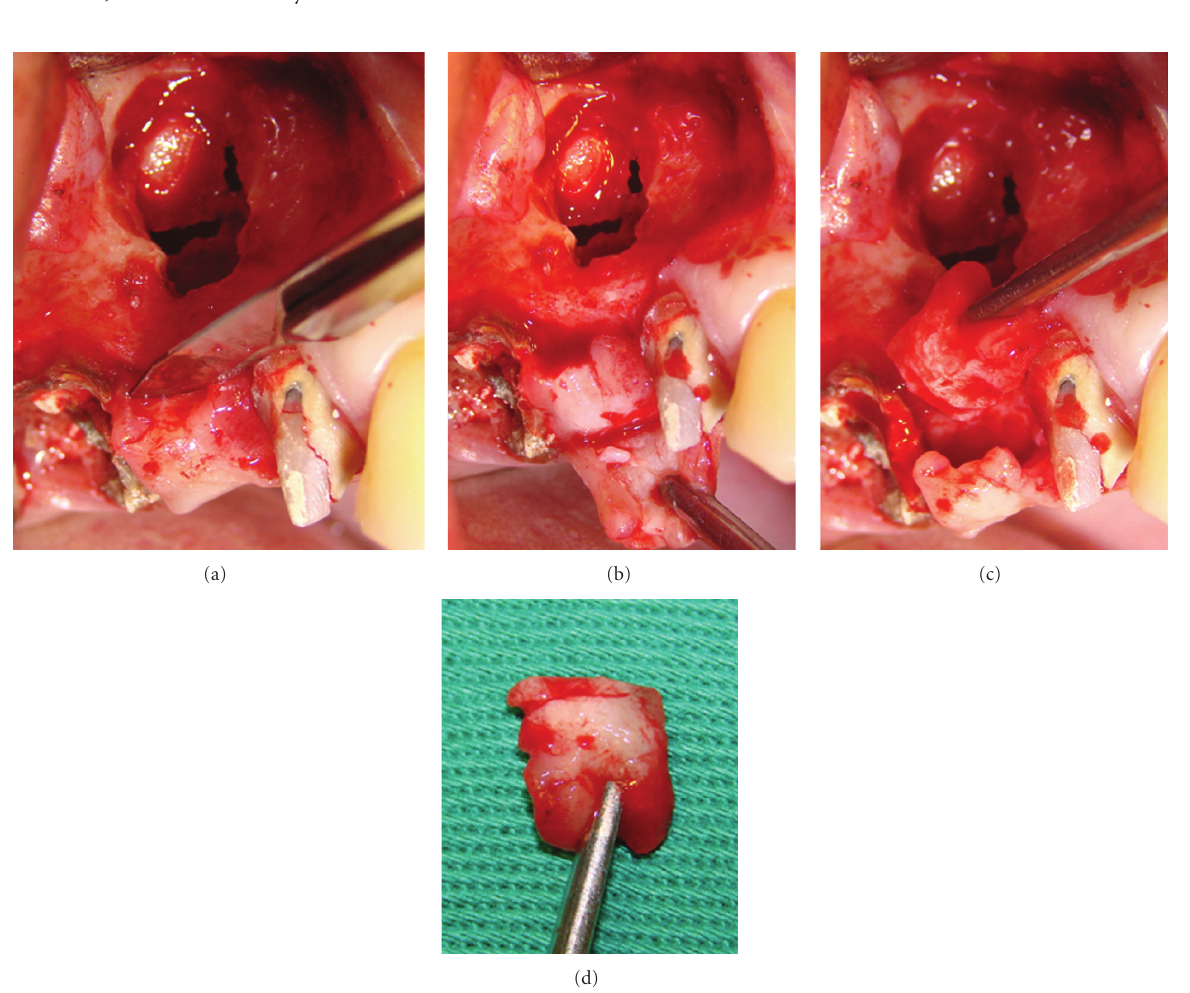
Figure 2: Images showing the sequence of removal of palatal